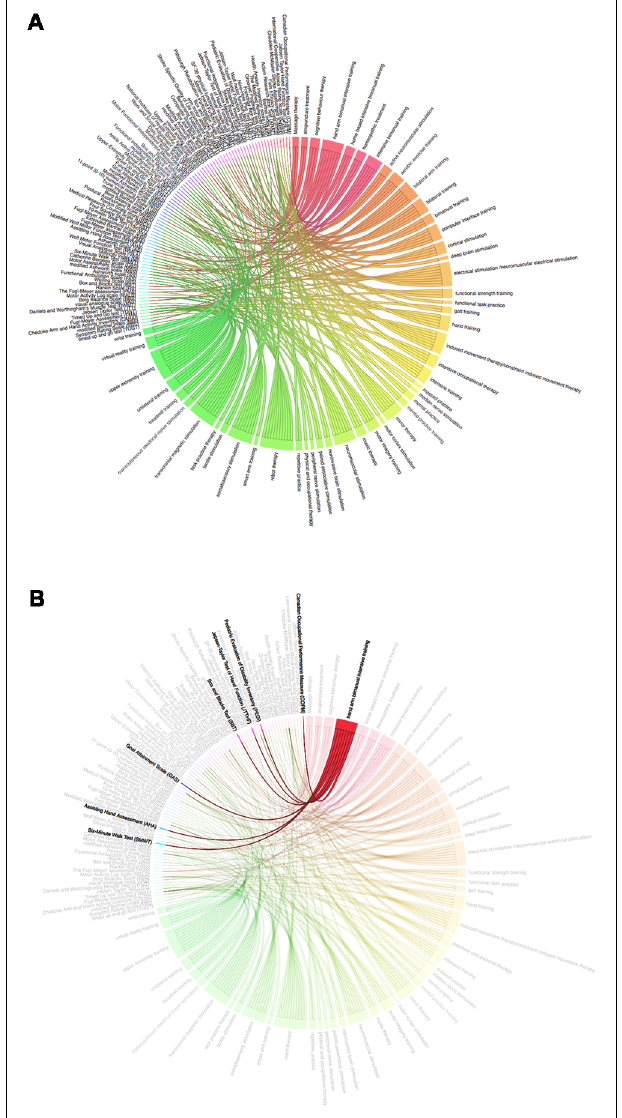
FIGURE 3 | Interactions of assessment scales and therapies. (A) Interactions of assessment scales and all therapies. (B) Interaction of HABIT and assessment